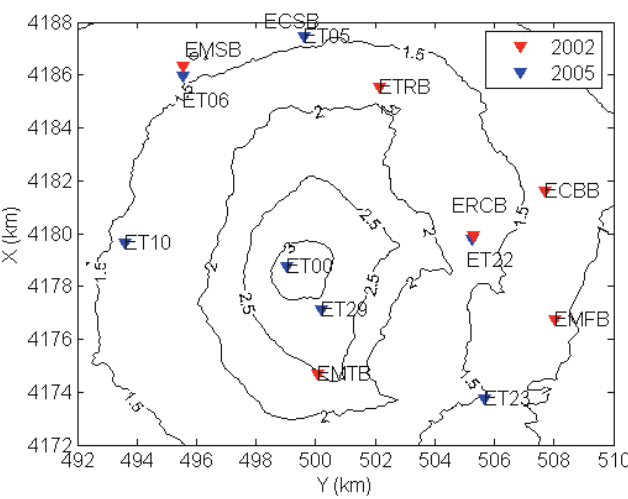
Figure 1. Map of the arrays used for the dispersion analysis, as installed in 2002 (blue triangles) and 2005 (red triangles).